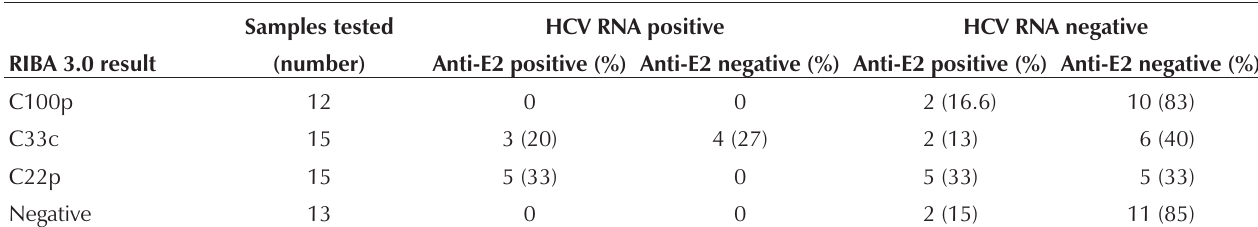
TABLE 1 Detection of anti-HCV-E2 in recombinant immunoblot assay RIBA 3.0 indeterminate and negative samples Samples tested HCV RNA positive HCV RNA